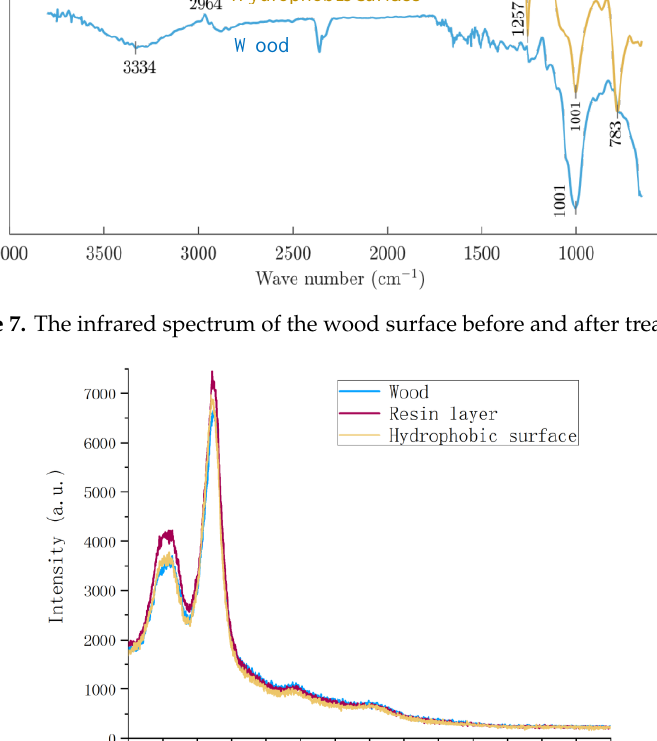
Figure 8. X-ray di ff raction pattern of untreated wood samples, resin layer, and hydrophobic surface on wood.